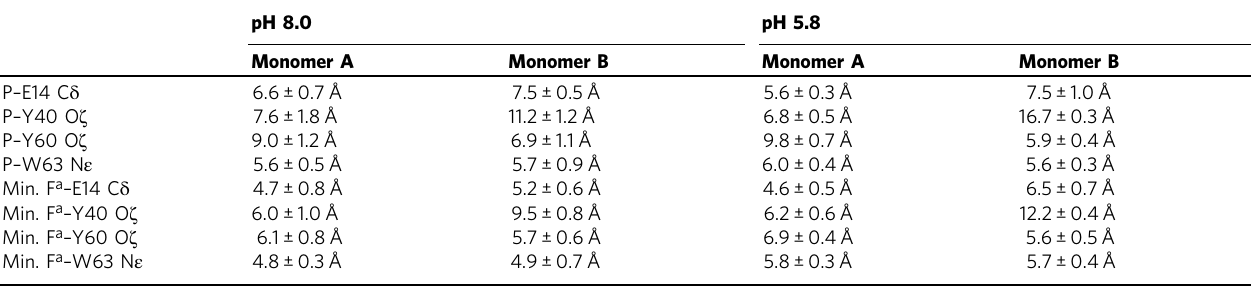
Table 2 Protein-substrate distances extracted from the NMR-re fi ned structural models.